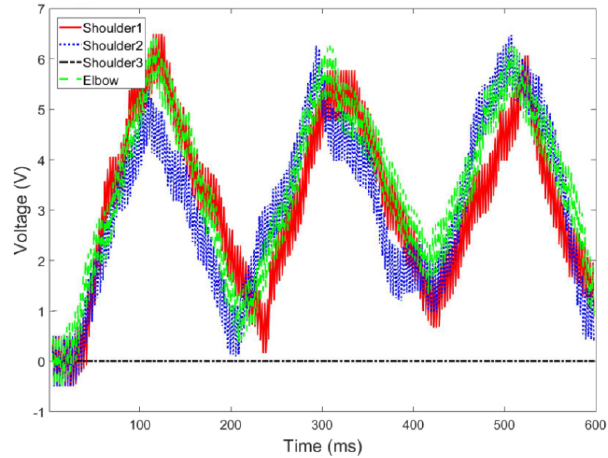
Figure 14. Control signals for the sliding mode controller (SMC).